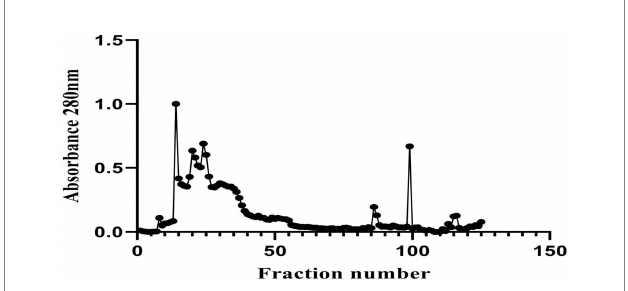
FIGURE 2 Elution profile of Glutamicibacter mysorens by using Sephadex G-10 column chromatography.